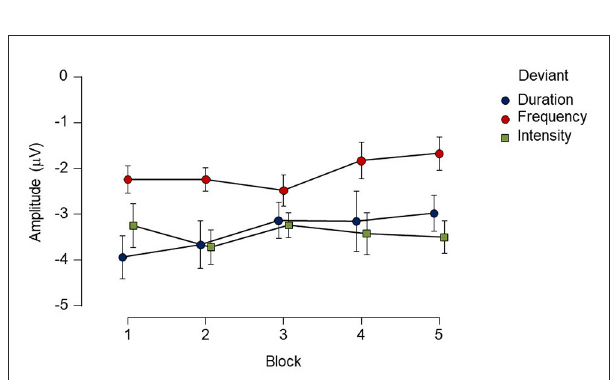
FIGURE3 Mean amplitude and standard errors (SE) of each deviant type for each block recorded over a 12-h period in the healthy control group. While there was main effect of deviant type, no reliable main effect of block or interaction was found. Points represent mean amplitude from each deviant type. Vertical extended lines indicate the standard error